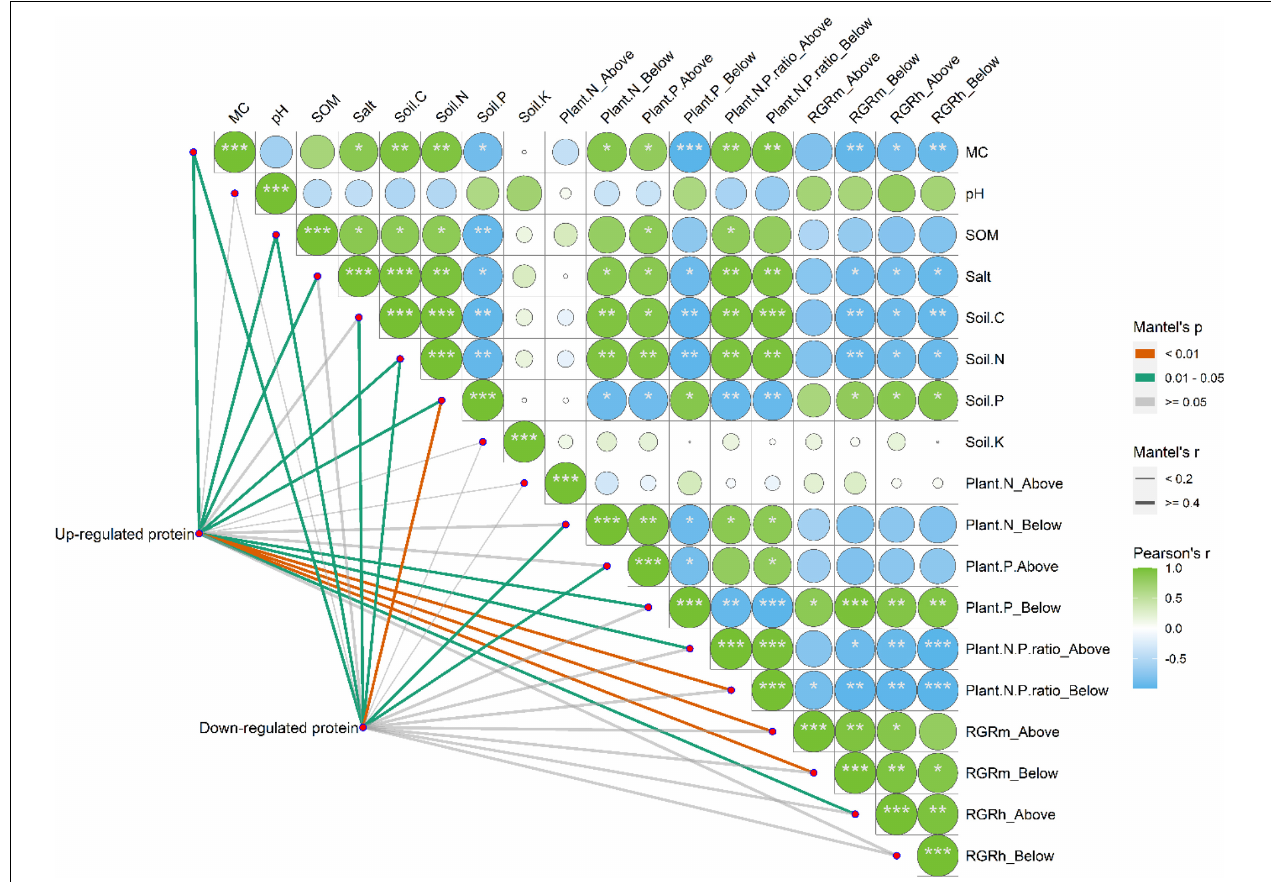
FIGURE 11 | Pairwise comparisons between environmental parameters and the up-regulated and down-regulated proteins of S. salsa under different habitats. The up-regulated and down-regulated proteins were correlated to each environmental parameter by partial Mantel tests. Line width indicates the Mantel’s r statistic for the corresponding correlation coefficient, and line color represents the statistical significance. The color gradient and square represent Spearman’s correlation